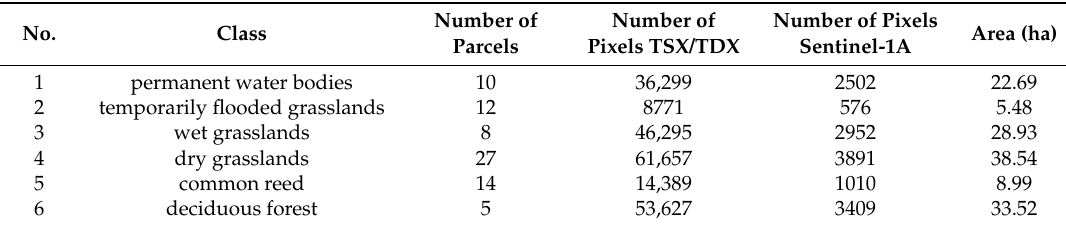
Table 4. List of thematic classes finally considered in mapping, the number of parcels, the number of pixels and their